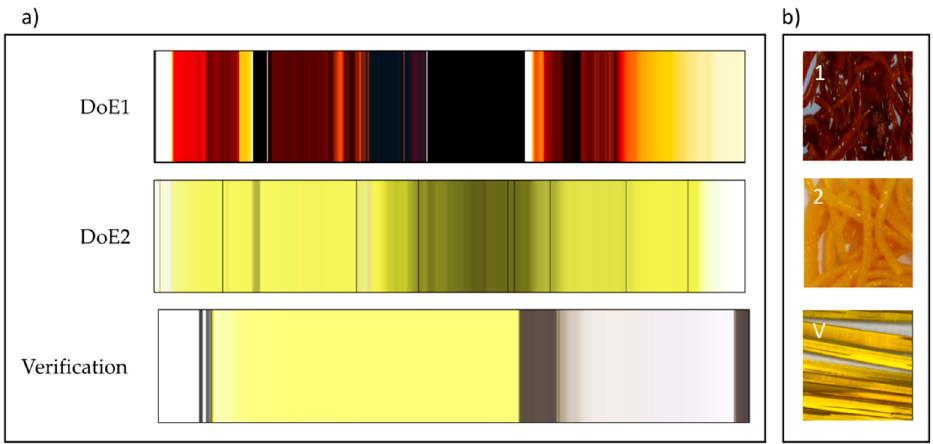
Figure 10. ( a ) Visualization of absorbance spectra of all experiments: DoE1, DoE2, verification. DoE1: ≈ 2000 spectra collected in 5 h; DoE2: ≈ 1500 spectra collected in 3 h; Verification: ≈ 650 spectra collected in 2 h. ( b ) Representation of samples from each DoE showing color and appearance of extrudates: (1) DoE1 opaque and very dark red (run 6: API 35% w / w , T = 150 °C, 100 rpm, 8 g/min); (2) DoE2 opaque and slightly orange (run 10: API 30% w / w , T = 140 °C, 200 rpm, 6 g/min); (V) Verification, transparent light yellow (run: API 20% w / w , T = 140 °C, 200 rpm, 6 g/min). Reproduced with permission from